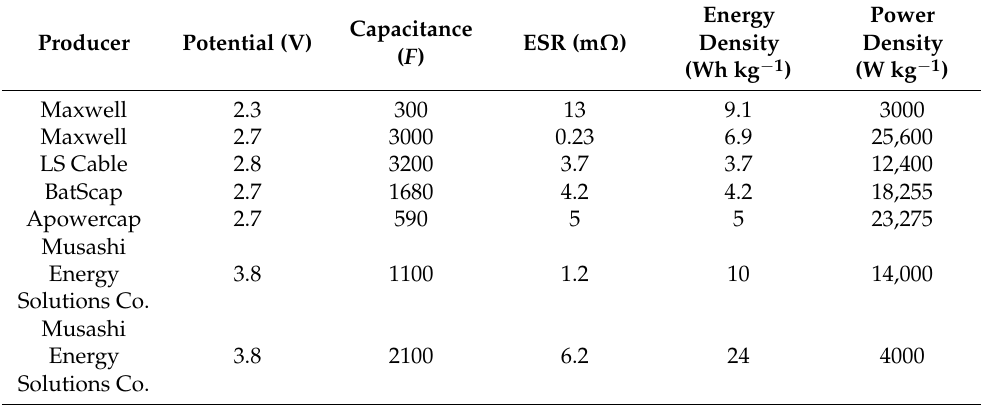
Table 2. Comparison of the performance characteristics of various commercial SCs, reproduced with permission from [82]. Copyright 2022,